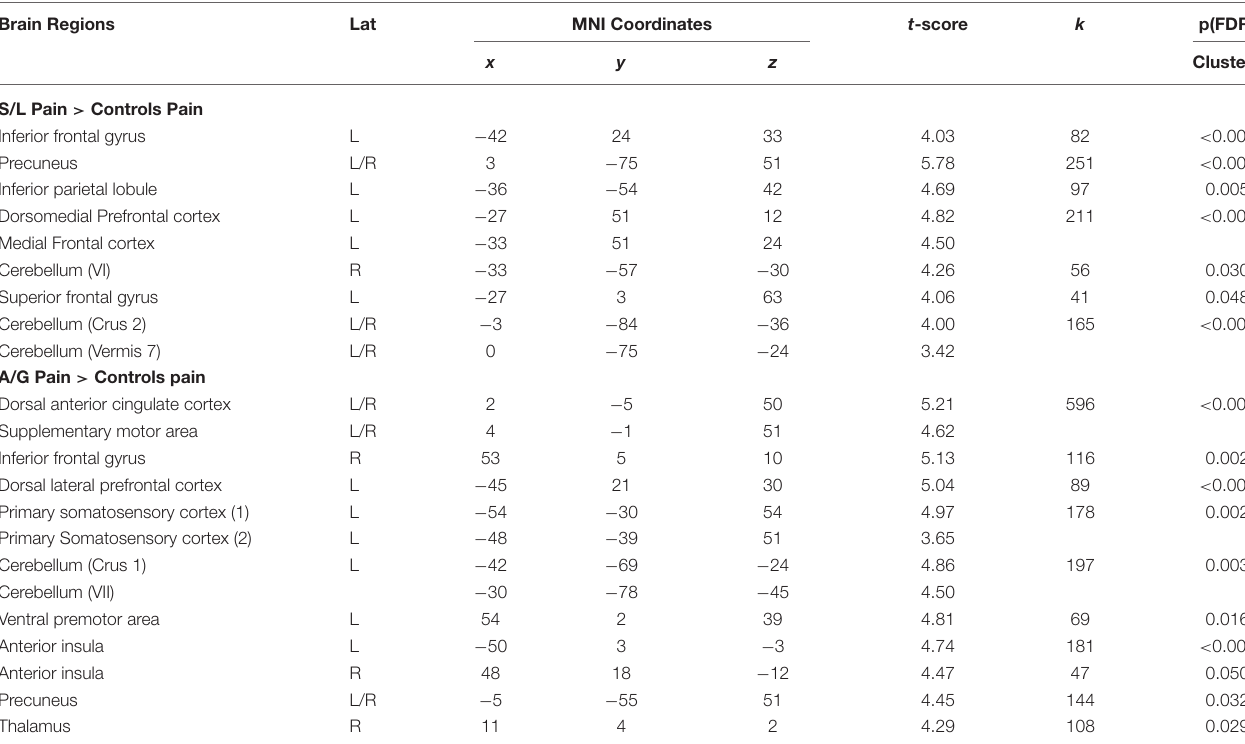
TABLE 3 | Regions showing significant between group effects for Pain vs. Pain contrasts in the responder groups relative to contrasts. Brain Regions Lat MNI Coordinates t -score k p(FDR) z